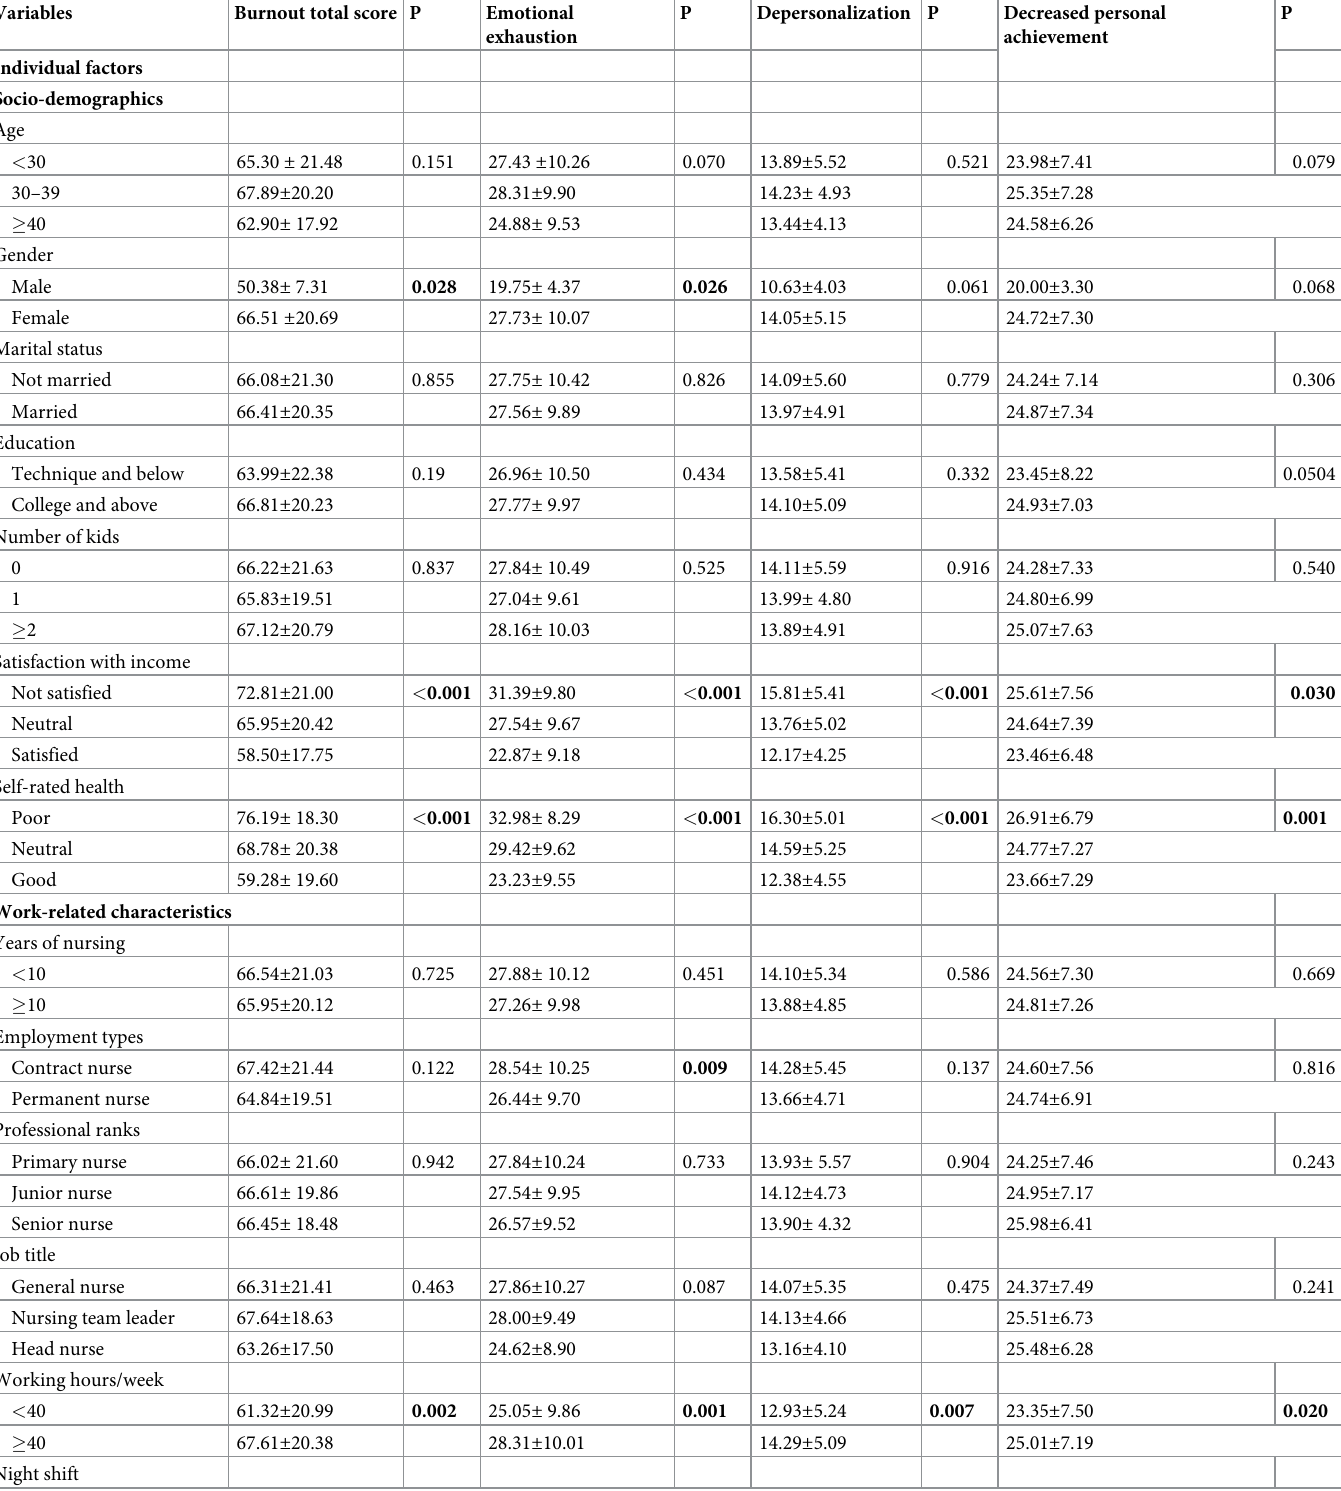
Table 2. Comparisons of burnout scores by various individual and environmental